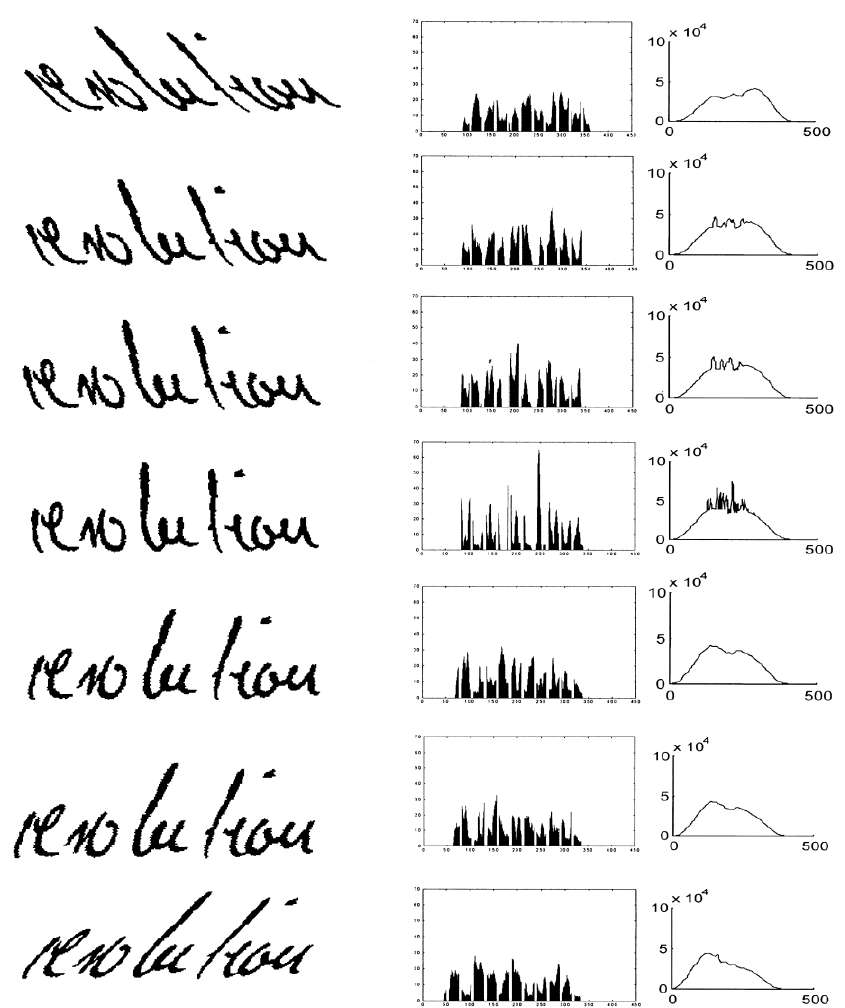
Figure 3. From left to right: slanted words, corresponding histograms and maximum intensity curves of WVD (Wigner–Ville distribution).